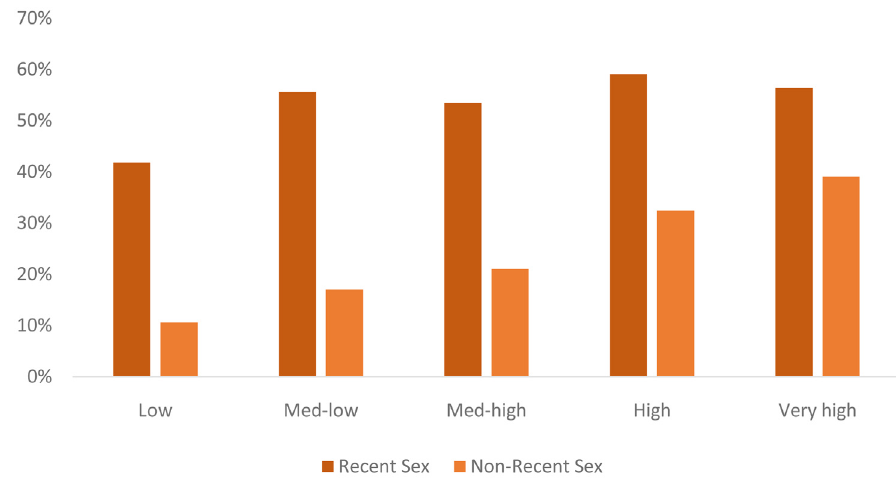
Figure 5. Recent sex and non-recent sex CPR by never-married category. This figure shows the average contraceptive prevalence rate (CPR) for never-married women who have had recent sex and non-recent sex for each of the five categories developed based on level of sexual